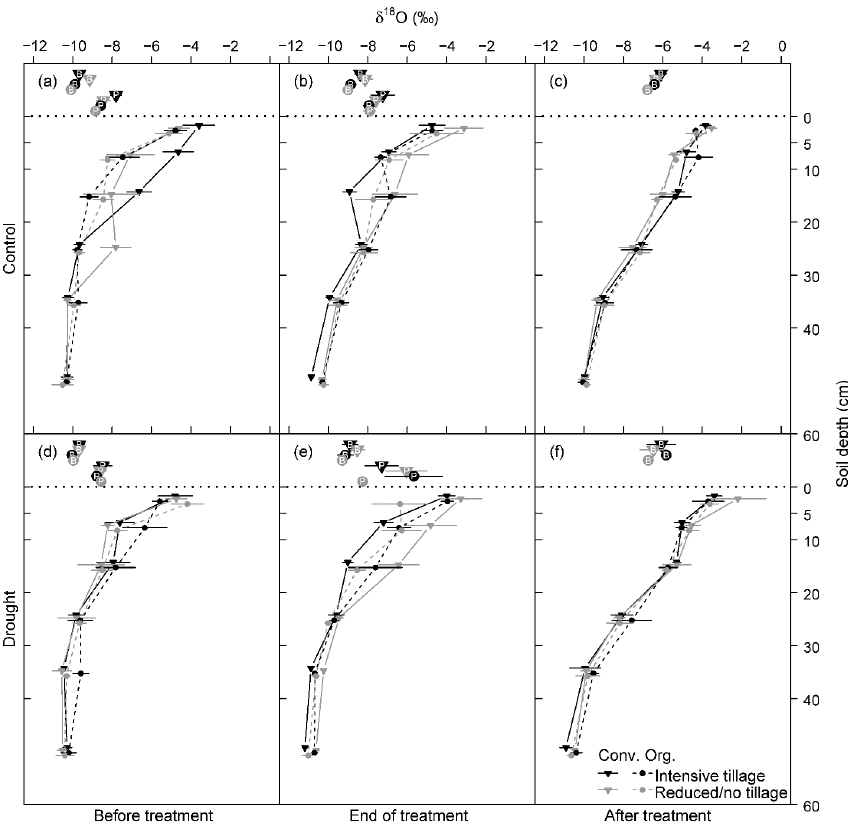
Figure 3. δ 18 O values of soil water from different depths and plant xylem water in each cropping system (a, d) before the drought treatment on 7 May, (b, e) at the end of the drought treatment on 25 June, and (c, f) after the treatment on 11 July 2018 (Conv. for conventional and Org. for organic). Horizontal dotted lines separate isotopic composition of soil and plant samples (P for pea and B for barley). Pea plants were already senesced in early July; therefore no stable water isotope data are available after the drought treatment. Means and 1SE (standard error; horizontal bars) are given for each cropping system ( n =